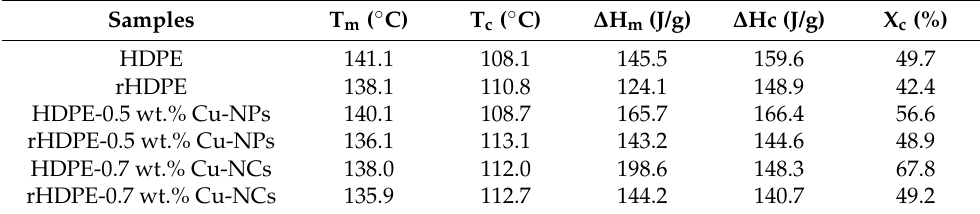
Table 1. Differential scanning calorimetry parameters for